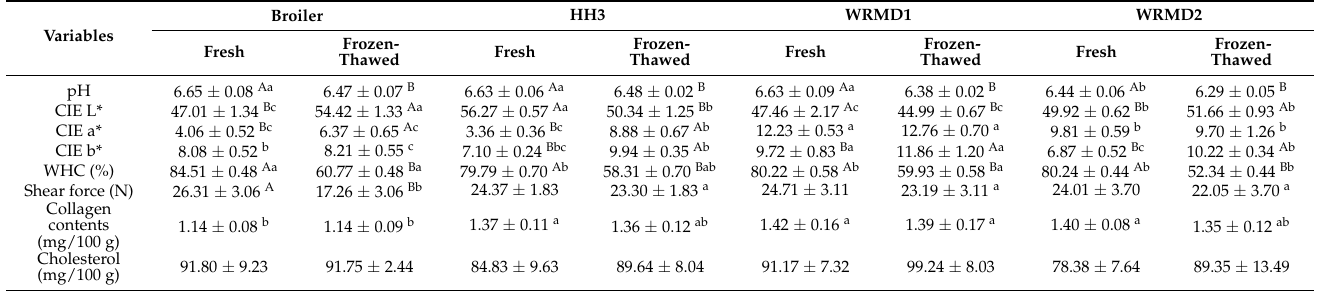
Table 2. Comparison of quality properties of fresh and Frozen-Thawed chicken meats from Korean native chickens and